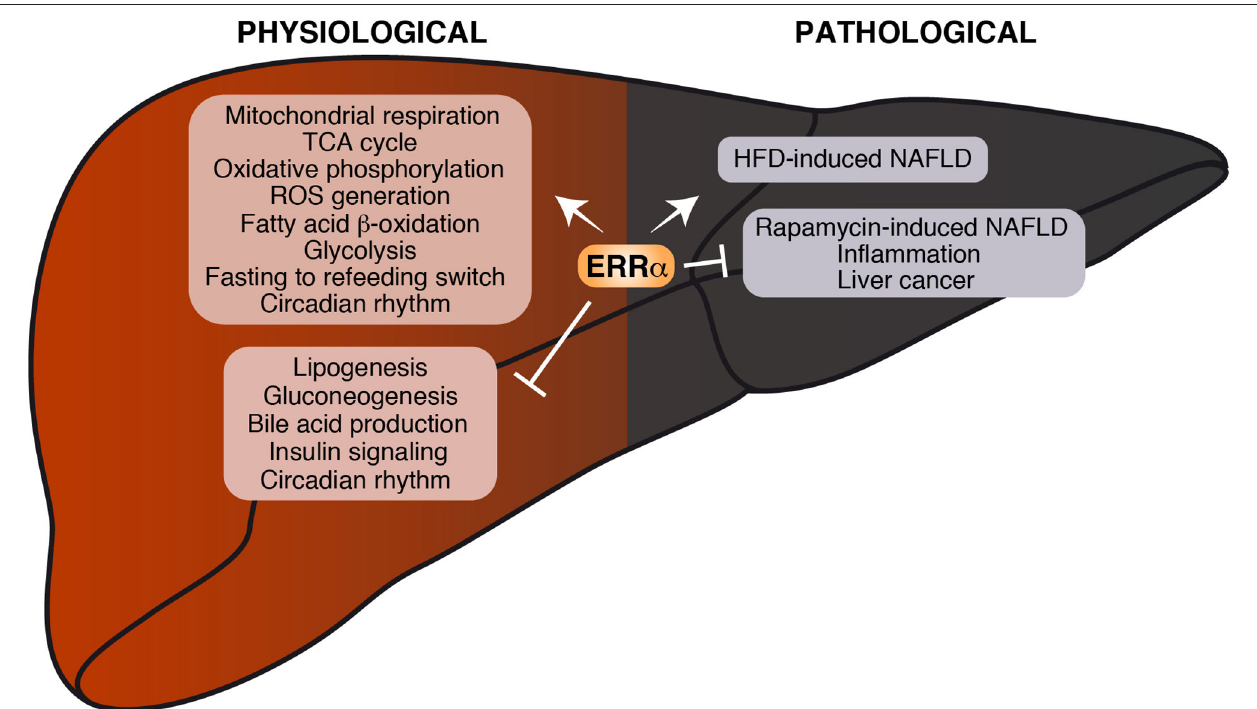
FIGURE 3 | Current knowledge on the role of ERR α in liver physiology and pathology. Biological processes found either positively or negatively regulated by ERR α are shown. Under physiological conditions, ERR α can stimulate mitochondrial function and nutrient catabolism and repress de novo lipogenesis, gluconeogenesis and insulin signaling. Under pathological conditions, ERR α promotes the development of HFD-induced NAFLD on one hand and represses inflammation and protects from the development of rapamycin-induced NAFLD and liver cancer on the